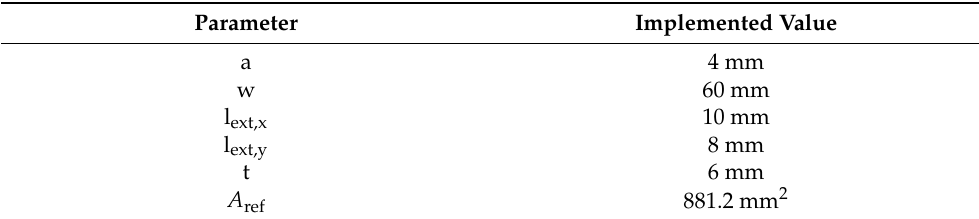
Table 2. Reference area